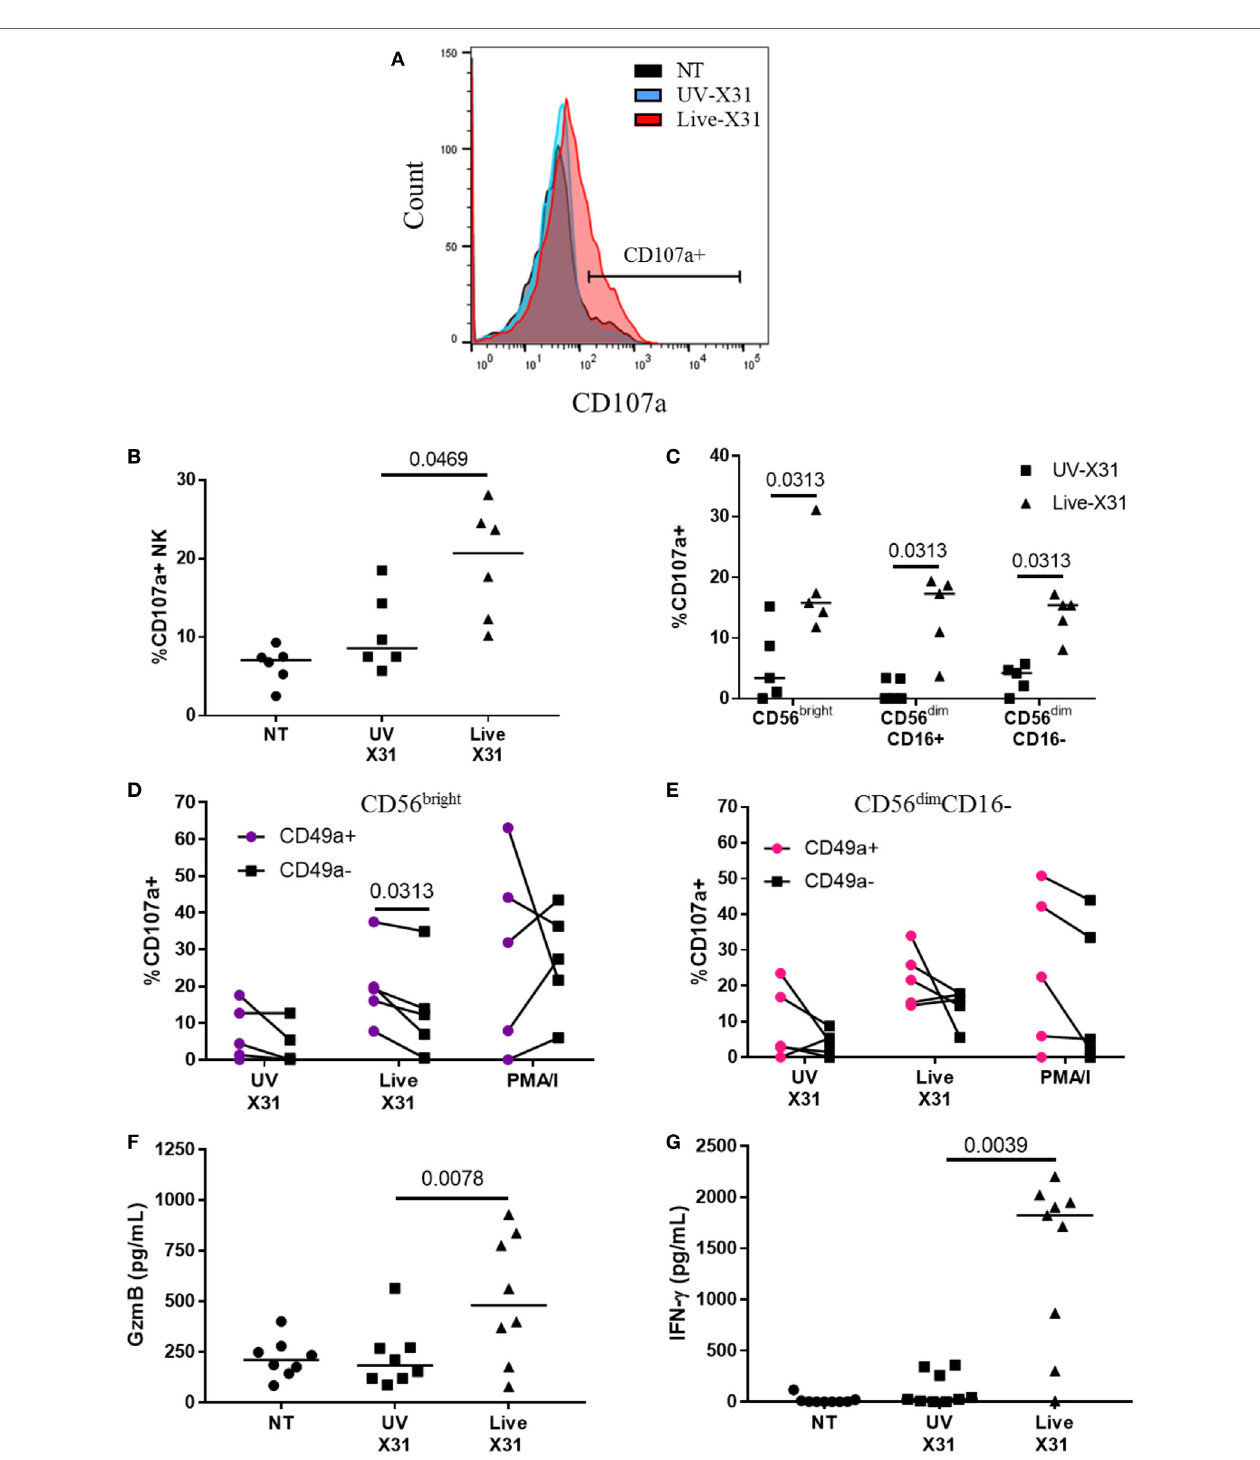
FigUre 7 | Natural killer (NK) cell activation in X31-infected human lung explants. (a,B) Representative flow plot and quantification of surface CD107a on explant NK cells 24 hpi ( N = 6). (c) Surface CD107a on NK cell subsets 24 h after X31 infection ( N = 5). Uninfected (NT) background CD107a expression was subtracted. (D,e) CD49a + and C49a − NK cell degranulation of CD56 bright (D) and CD56 dim CD16 − (e) NK cells following X31 infection and phorbol myristate acetate/ionomycin stimulation of lung explants ( N = 6). (F,g) Extracellular granzyme-B (GzmB) and IFN- γ in explant supernatants 24 h post-infection with X31 ( N = 8). Lines describe medians, statistical analysis performed by Wilcoxon signed-rank